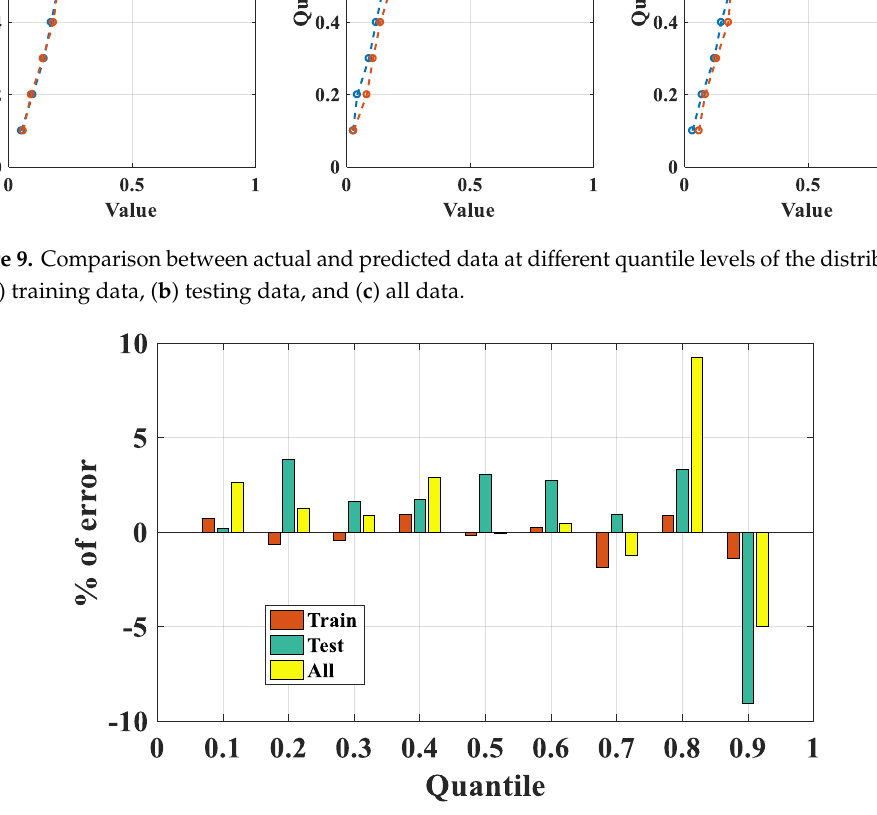
Figure 10. Percentage of error between quantile estimation for training, testing, and all data.